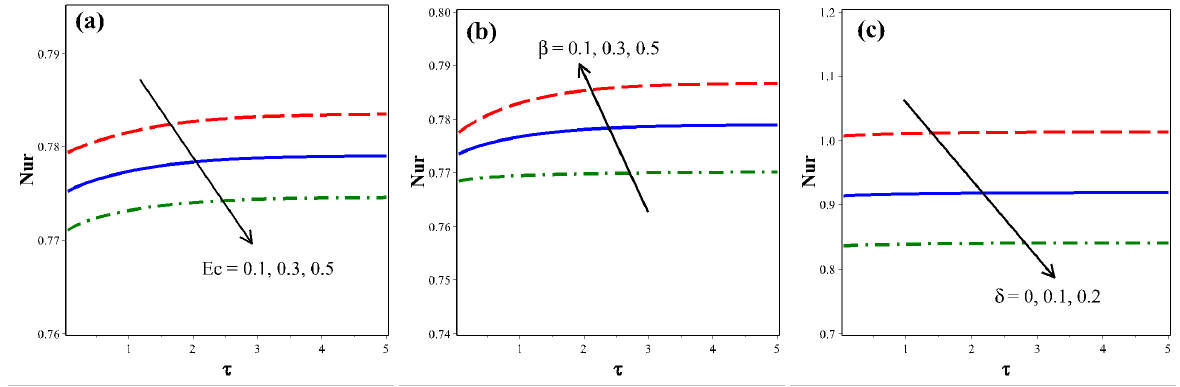
Fig. 5: Influence of Eckert number, stagnation parameter and thermal slip parameter on Nusselt number.